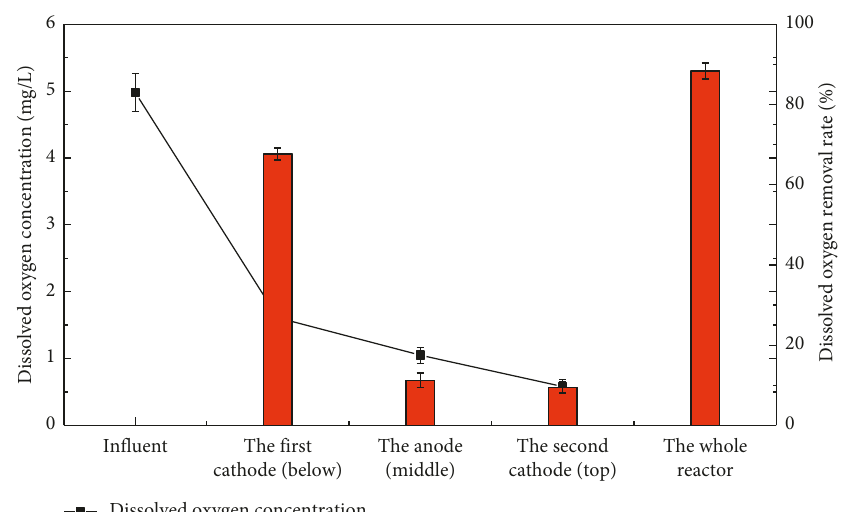
Figure 4: Dissolved oxygen concentration changes and removal rates at different effluent locations.